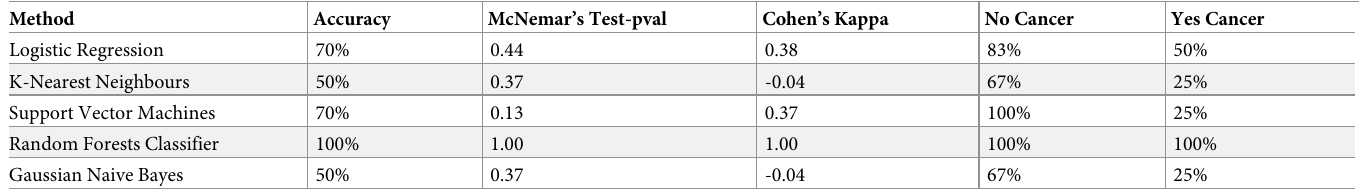
Table 8. Classification performance of various supervised classification algorithms for the prediction of cancer infiltration based on LV miRNA expression. Details are similar to Table